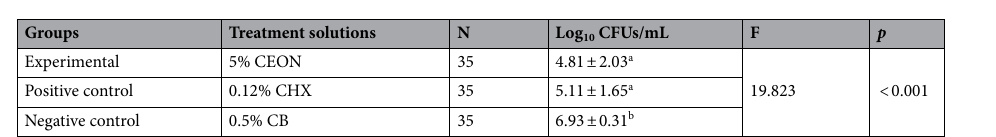
Figure 3. QLF-D red fluorescence images of 7-day-old mature oral biofilms after treatment with 5% CEON ( a ), 0.12% CHX ( b ), and 0.5% CB ( c ). CEON cinnamon essential oil nanoemulsion, CHX chlorhexidine gluconate, CB cocamidopropyl betaine.